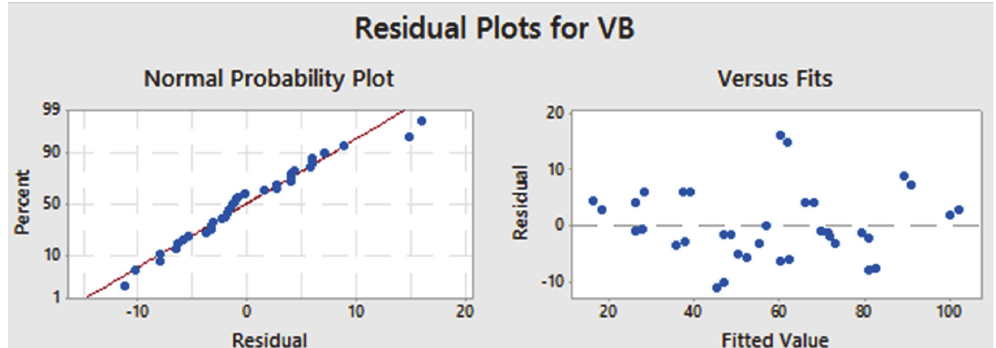
Fig. 13. Normal probability plot of residual and Plot of residual vs. fitted flank wear values Fig. 14 shows comparison of the second order model with the experimental value of surface roughness and flank wear. Correlations of experimental results with the second order model are 0.99 and 0.98 for surface roughness and flank wear, respectively and correlations of experimental results with linear